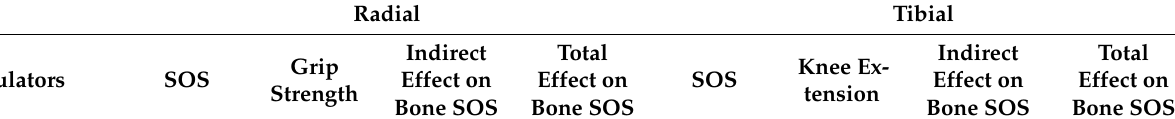
Table 4. Functional model of bone development results for the radius and tibia separately (total cohort). Values are β coefficients with standard errors in